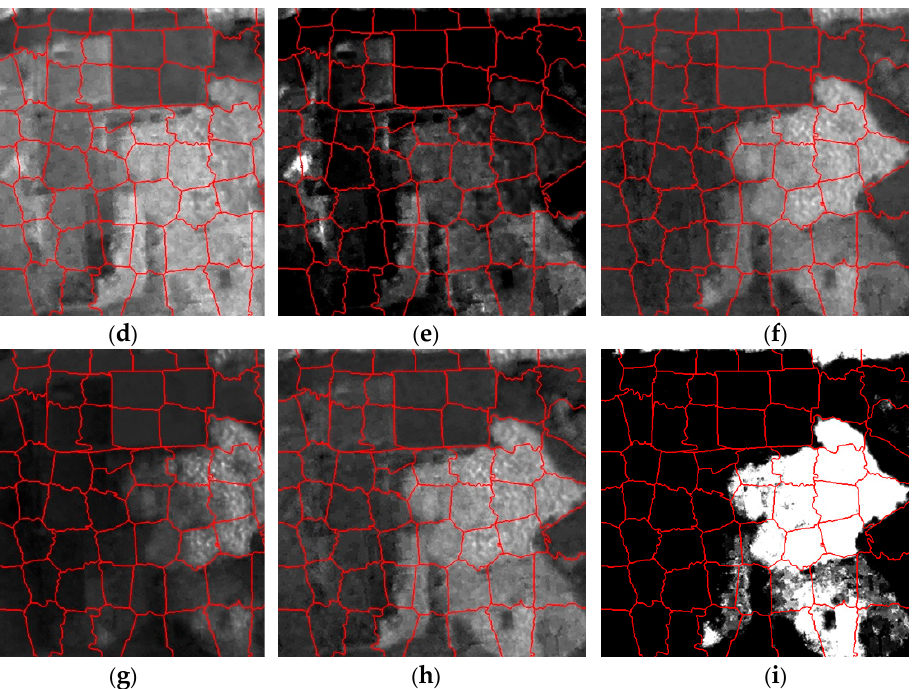
Figure 5. Example to illustrate the vegetation surrounding a building with similar heights. ( a ), ( b ), and ( c ) are the orthoimage, 3D point clouds with true color, and 3D point clouds with rendering color, respectively. ( d )–( i ) are the results of NGRDI, VARI, GLI, RI, ExG–ExR, and GGLI. The red lines denote the boundaries of the superpixels.